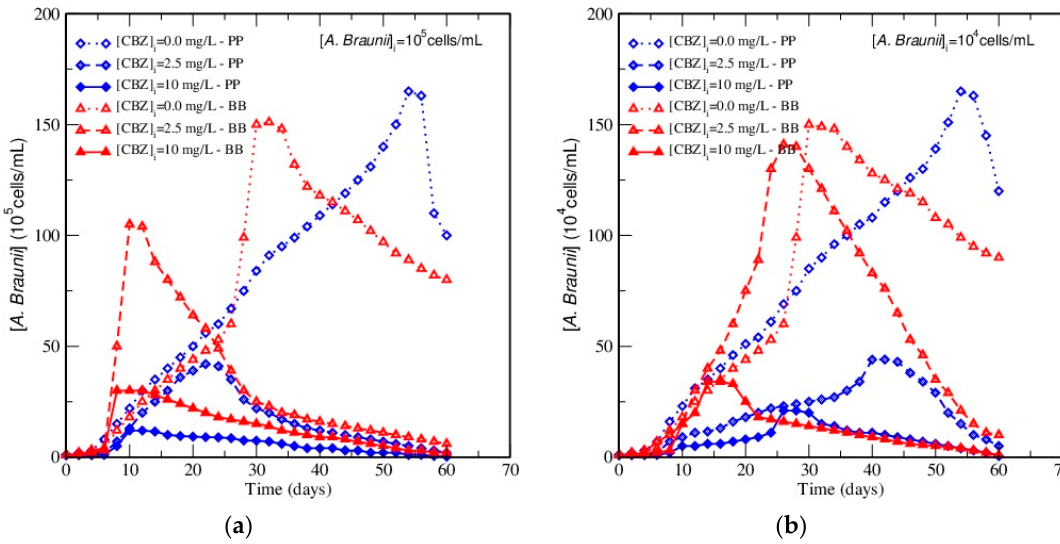
Figure 1. Growth curves of Ankistrodesmus braunii cultured in Bold’s Basal (BB) and proteose peptone (PP) media at different initial CBZ concentrations (0.0, 2.5, and 10 mg/L, respectively) for an initial inoculum concentration ( a ) 10 5 cells/mL, ( b ) 10 4 cells/mL, during 60 days of incubation.